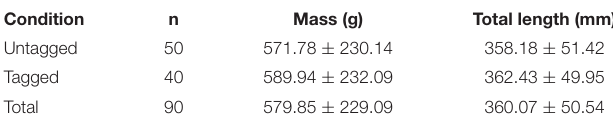
TABLE 1 | Morphometric measures (mass [g] and total length, TL [mm]) and sample size of European sea bass ( Dicentrarchus labrax ) tested in the swimming chamber for U crit trials depending on condition (untagged and tagged